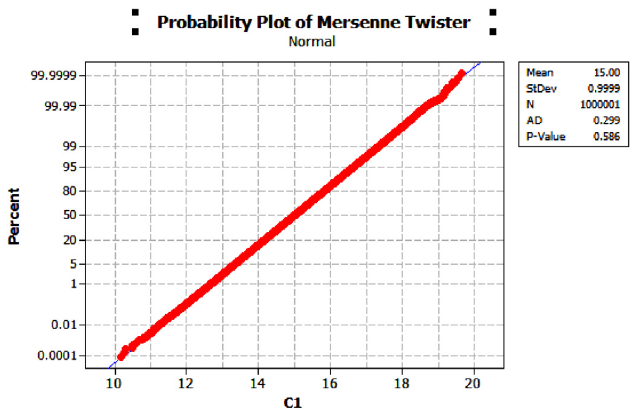
Fig. 5. The Anderson Darling normality